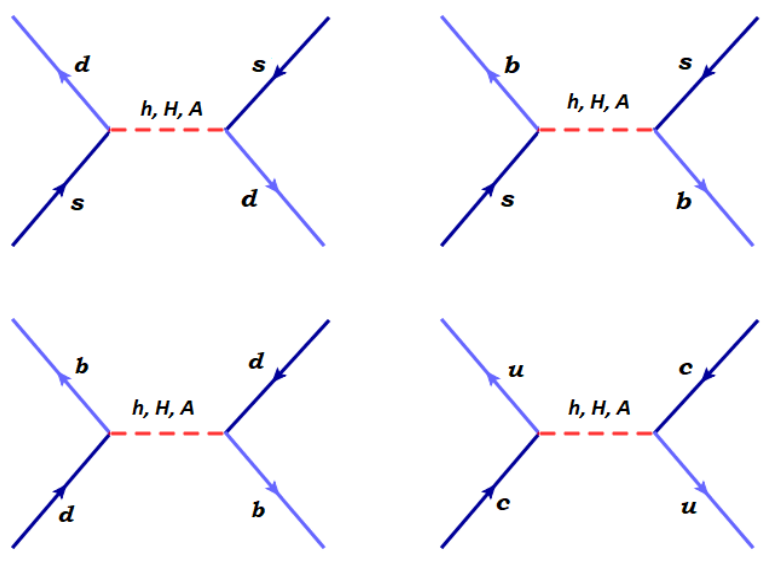
Figure 1 . Feynman diagrams for various FCNC processes mediated by tree-level neutral Higgs boson exchange: top left: K 0 (cid:0) K 0 mixing, top right: B 0 and bottom right: D 0 (cid:0) D 0